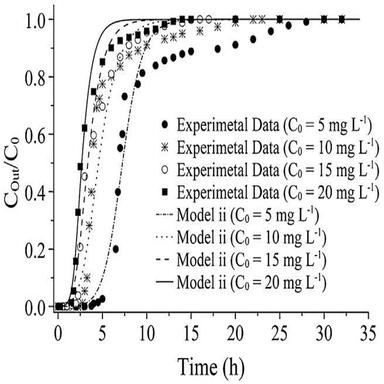
Breakthrough curves to analysis of influence of feed concentration in the mass transfer coefficient: experimental and simulated by model ii.